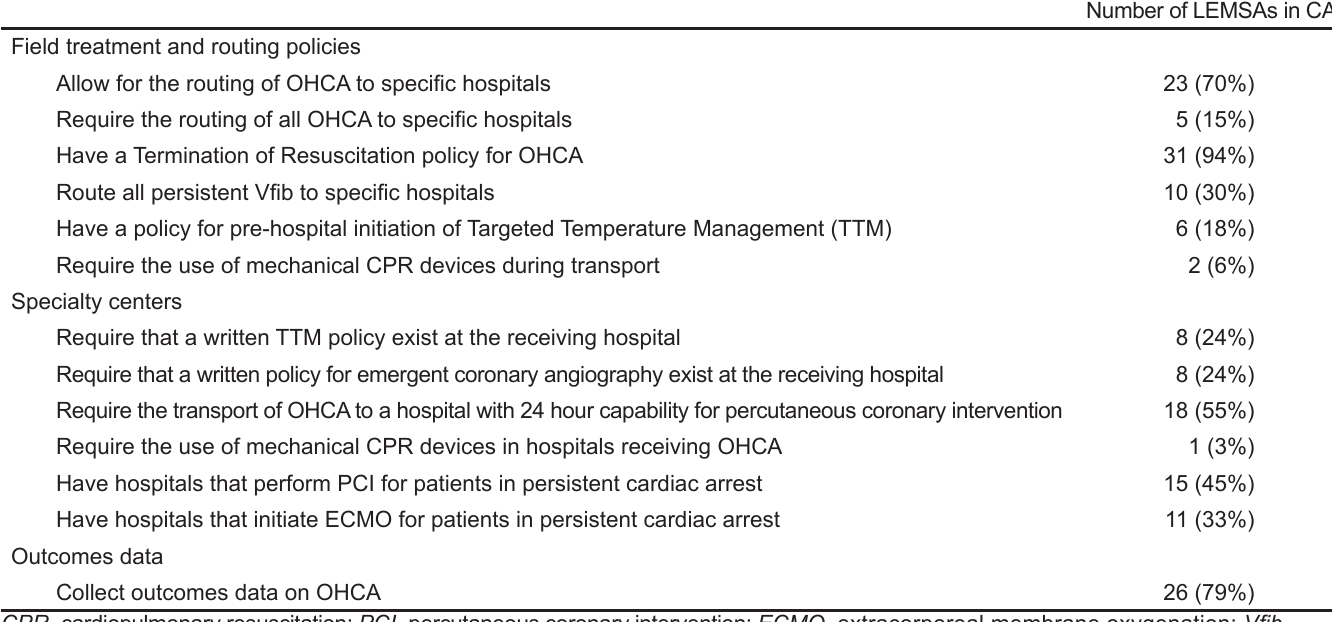
Table 1. Summary of the routing and treatment policies for out-of-hospital cardiac arrest (OHCA) among the 33 local EMS agencies (LEMSA) in